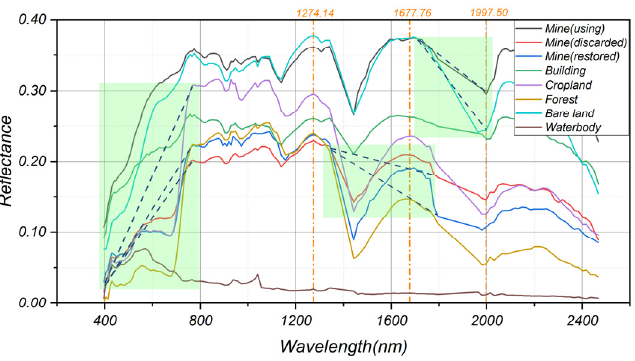
Figure 4. Spectral characteristic curve of 8 land cover types from ZY-1-02D in the study area. In addition, referring to the Landsat-8 Operational Land Imager (OLI) band char- acteristics, 6 main band values are extracted from ZY-1-02D (Table 2). Since ZY-1-02D hyperspectral data has a relatively low signal-to-noise ratio, calculation using a single band is susceptible to noise [37], so in this study, we calculated the average surface reflectance by combining different bands and set the average value as a band